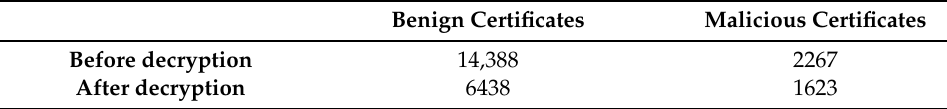
Table 1. Sample size of the dataset.